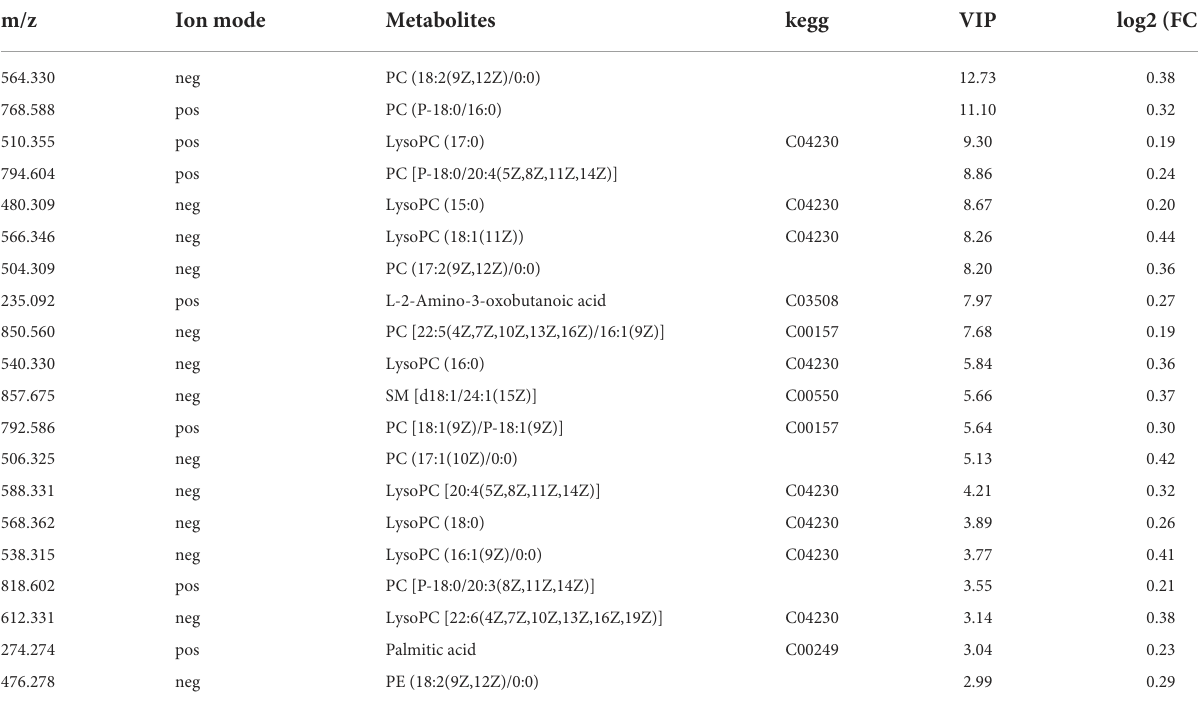
TABLE 2 The top 20 metabolites contributed most to the difference in metabolic profiles.